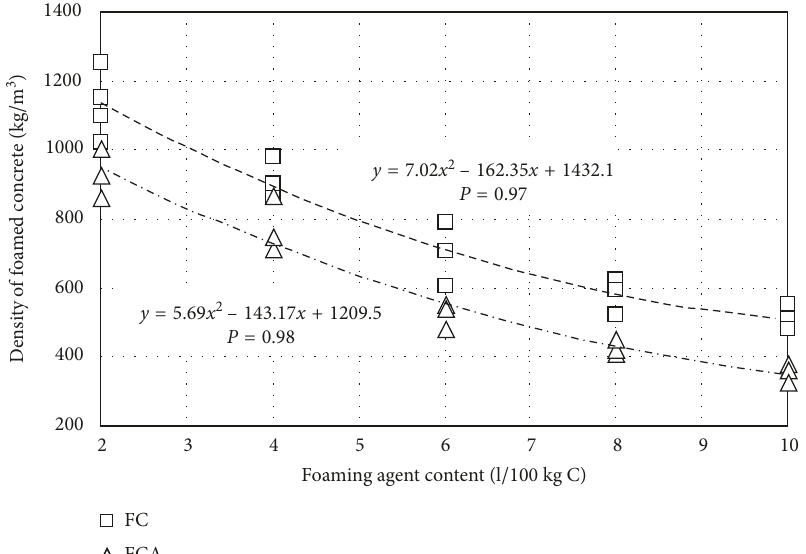
Figure 1: Apparent density of foamed concrete specimens FC and FCA as a function of foaming agent content.